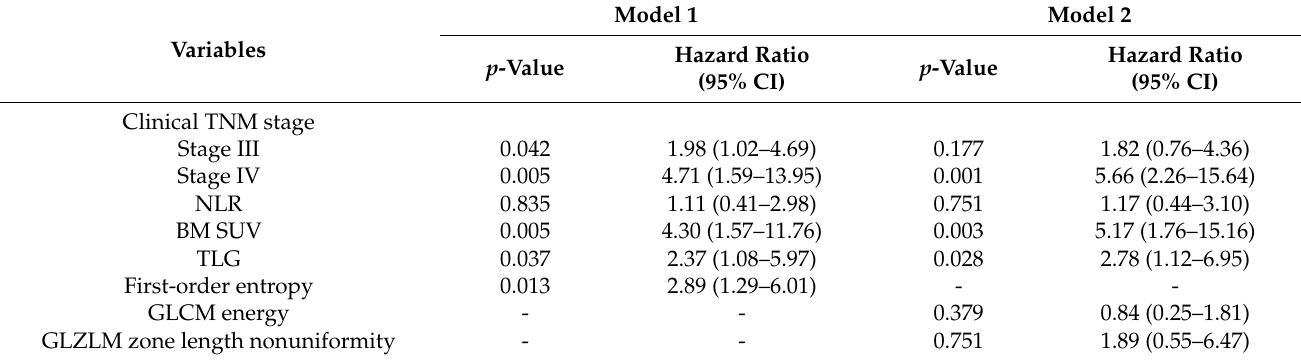
Table 3. Multivariable analysis for predicting overall survival after adjustment for age and sex.